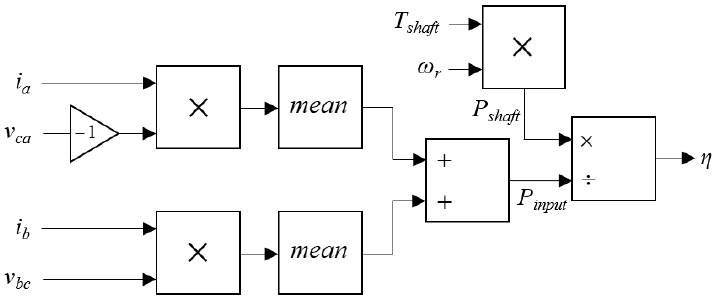
Figure 10. Efficiency computation.